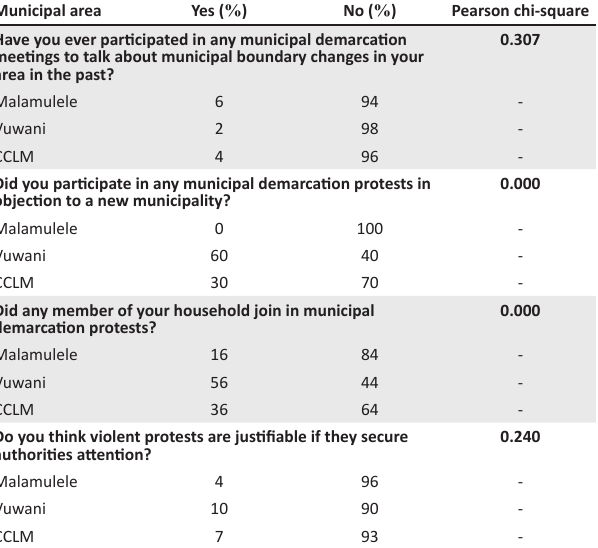
TABLE 1: Participants’ involvement in the municipal demarcation meetings and protests Municipal area Yes ( % ) No ( % ) Pearson